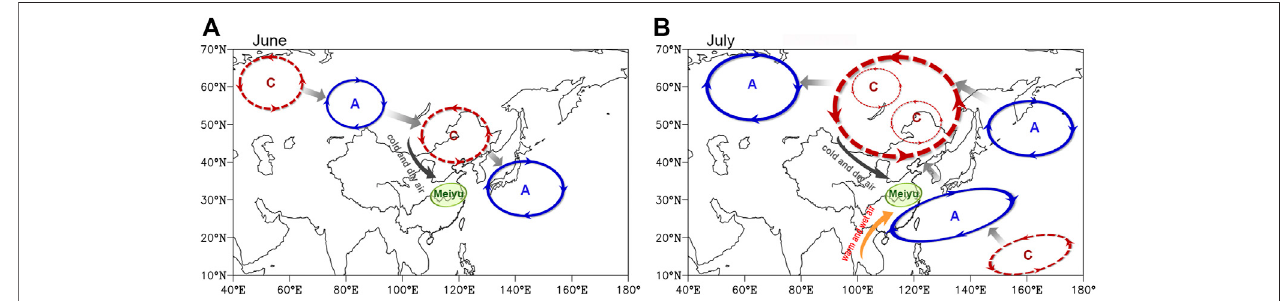
FIGURE14| SchematicdiagramforcirculationsforMeiyurainfallonscaleofQBWOinJune (A) andJuly (B) 2020(Solidblue/dashedredcyclesandblue/redletter A/C denote anticyclonic/cyclonic fi ltered circulation. Gray arrows denote propagation of wave train. Filtered circulation associated with valley phase ofMeiyuis opposite to that at peak phase, as